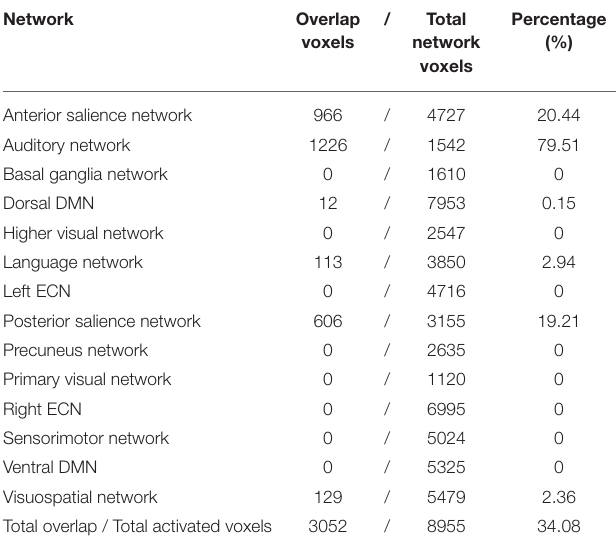
TABLE 4 | Brain network mapping of the brain regions activated by acupuncture at ST36.